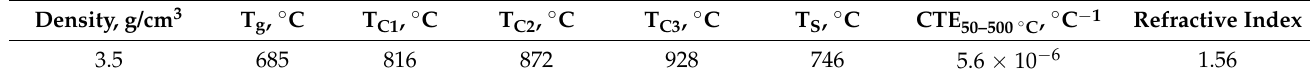
Table 1. Measured properties of the synthesized glass.